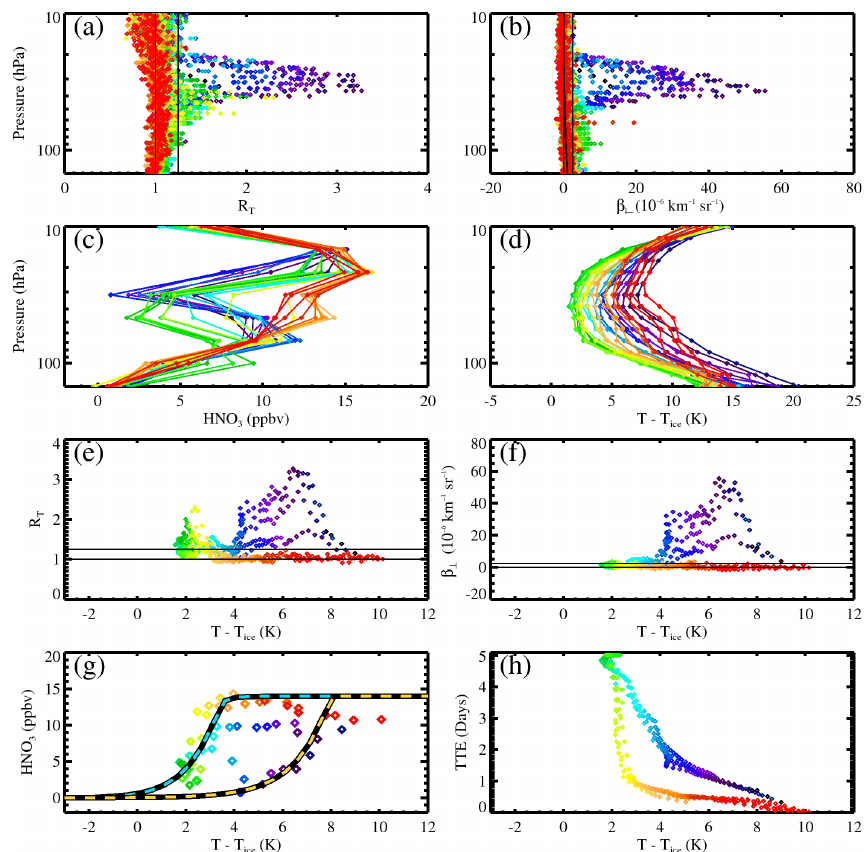
Fig. 15. As Fig. 8, but for orbit track 12 on 2 June 2008 (see Figs. 12f and 13f). Note scale changes in (a, b, e, f) from Fig. 8.